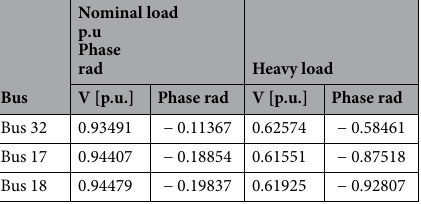
Table 8. Power flow results of the system when SPVG PV-model is connected at bus 10.